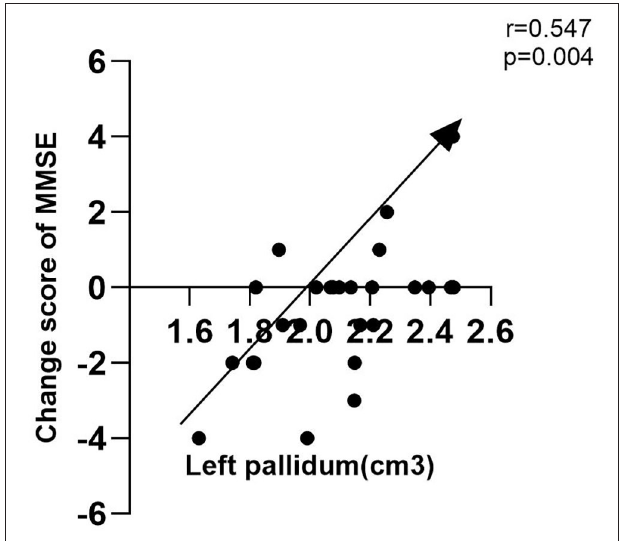
FIGURE 1 | Association between MMSE change score and globus pallidus